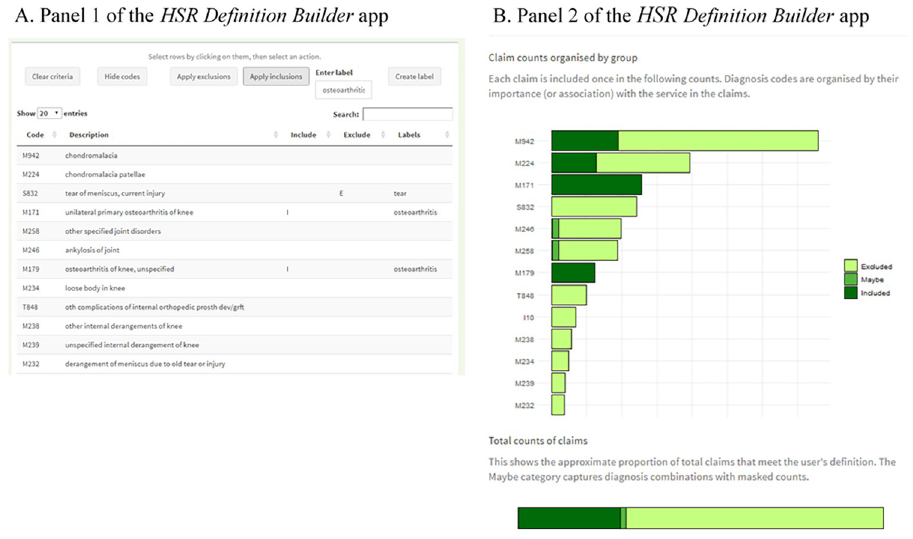
Fig 2. Two components of the HSR Definition Builder Shiny application, which allows users to explore diagnostic indications on claims data and run their own inclusion and exclusion criteria counts. The example above shows our selected indications for 2016 outpatient claims for knee arthroscopy. A . The first panel lists the diagnoses codes associated with this procedure. Users have options to select these codes and put them as exclusion or inclusion criteria. Users can also select rows and create a label for multiple diagnosis codes. B . The estimated counts of claims that fall under the user’s definition. The bar chart shows the claims with each diagnosis code. The donut chart shows the overall included, excluded or ‘maybe’ counts. The ‘maybe’ category exists due to the masking of small counts from the claims data.